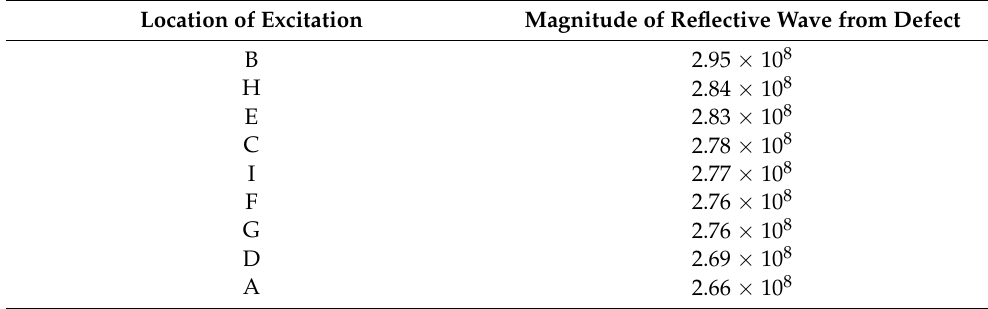
Table 4. Summed magnitudes of defect-induced reflective waves for each excitation location where stiffener is attached on the right side of panel.